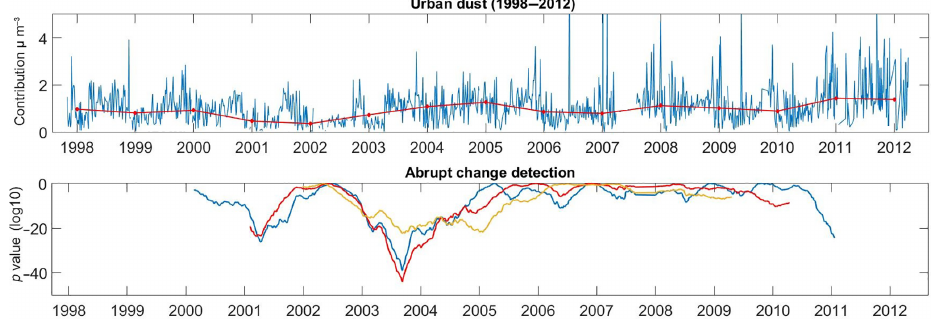
Figure 9. Top panel: time series of urban dust contribution to PM 2 . 5 and the annual median in red. Bottom panel: p value from a Mann– Whitney hypothesis test comparing the median of both halves of a sliding window, repeated for three different window lengths (320, 480 and 640 days for blue, red and yellow, respectively).